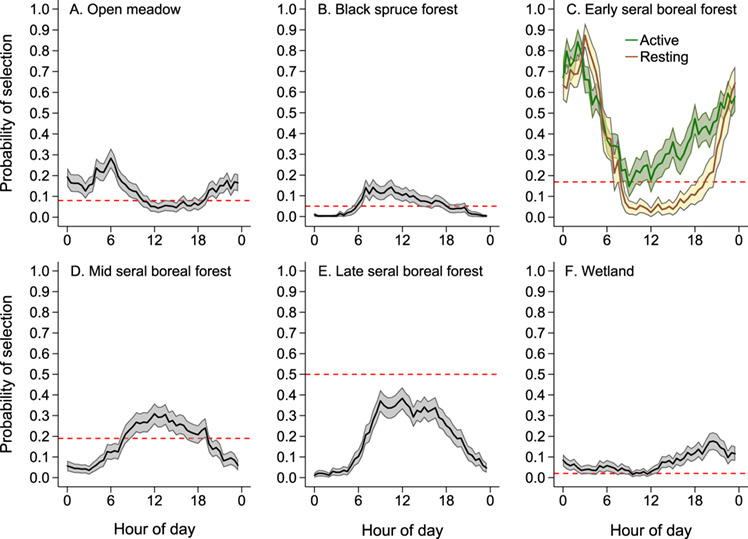
Probability of selection of each habitat type (A–F) by captive adult female moose (n = 6) at the Kenai Moose Research Center on the Kenai Peninsula, Alaska, USA from May through August 2015. Predicted values with 95% confidence intervals from mixed-effect logistic model regression against time of day (0.5 h time periods starting at 0:00) after selecting the best model describing probability of habitat selection for each habitat. Only the top model for early-seral boreal forest (C) included the interaction term between activity status and time of day. Horizontal red dashed line indicates the proportion of the total area each habitat encompassed (e.g. late-seral boreal forest comprised 0.5 or 50% of all vegetation within the study area).